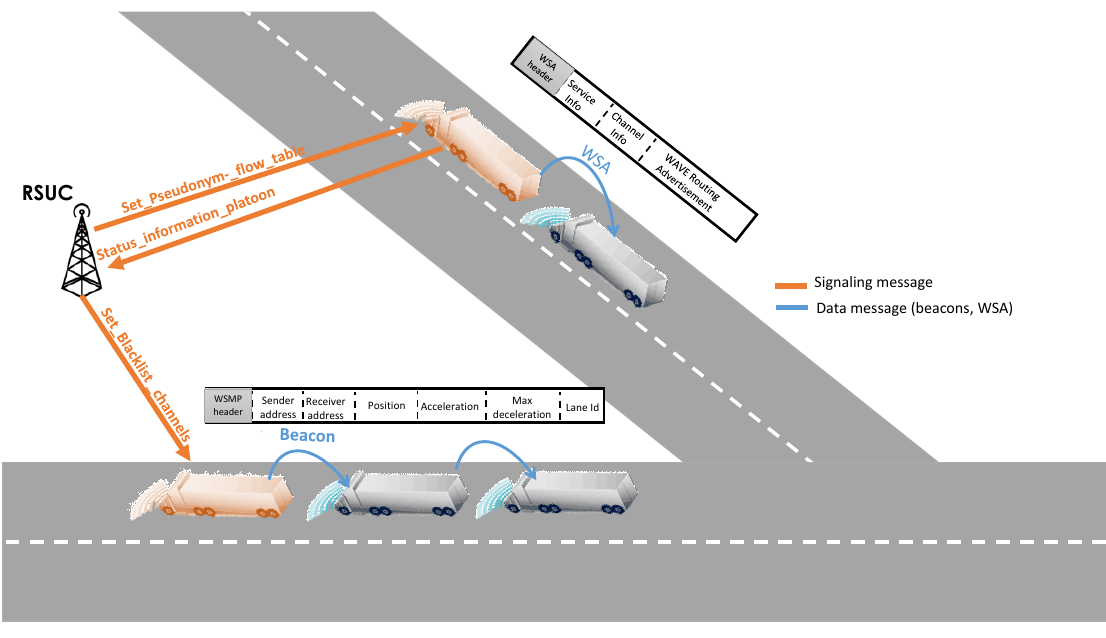
Figure 3. SDN-enabled